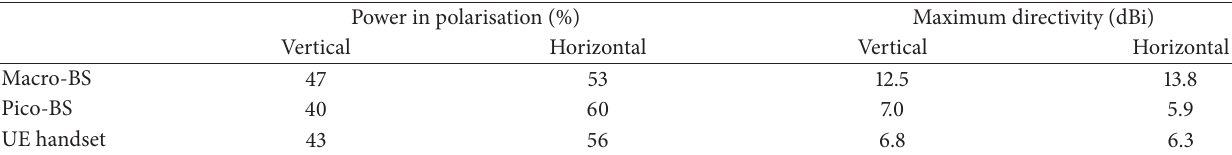
Figure 4: Measured antennas (top) and total power radiation patterns (bottom). (a) Macro-BS. (b) Pico-BS. (c) UE handset. Table 3: Radiation pattern